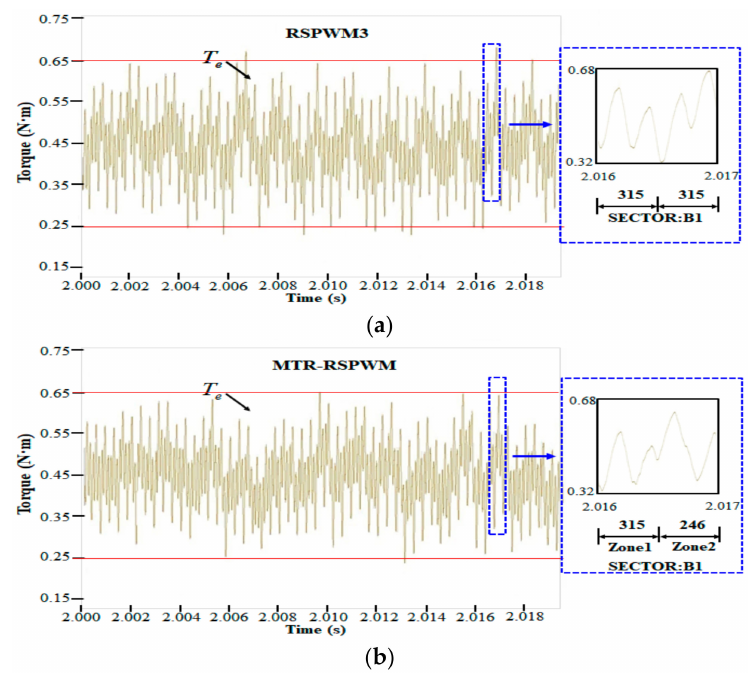
Figure 12. Experimental waveforms of output torque: ( a ) RSPWM3; ( b ) MTR-RSPWM.